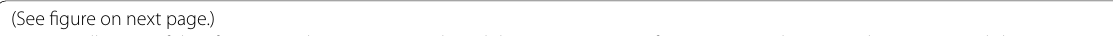
figure on next Fig. 3 Collection of data from several instruments on board the RBSP-B spacecraft on 19 September 2012. The upper panel shows an energy-time spectrogram (color-coded) for the entire day, while the second panel shows the level of spacecraft charging inferred for the same period. Panels 3, 4, and 5 show various wave modes identified from the RBSP sensors (as described in the text). The lower panel shows the spacecraft geocentric radial distance as a function of